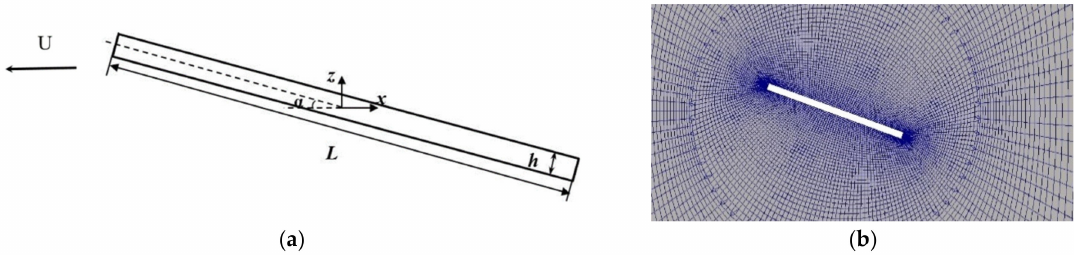
Figure 1. Draft of the problem under consideration ( a ) and fragment of the computational mesh ( b